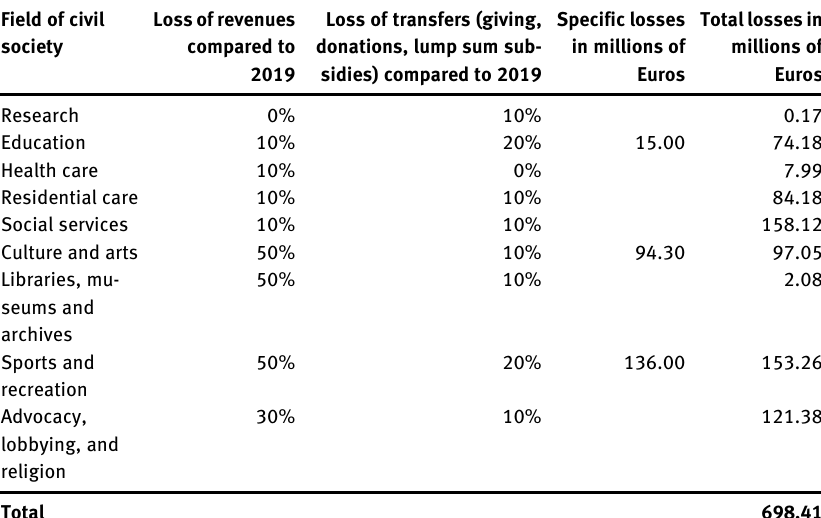
Table  : Estimation of fi nancial losses for CSOs in different fi elds of activity (based upon data collected by Leisch, Pennerstorfer, and Schneider 